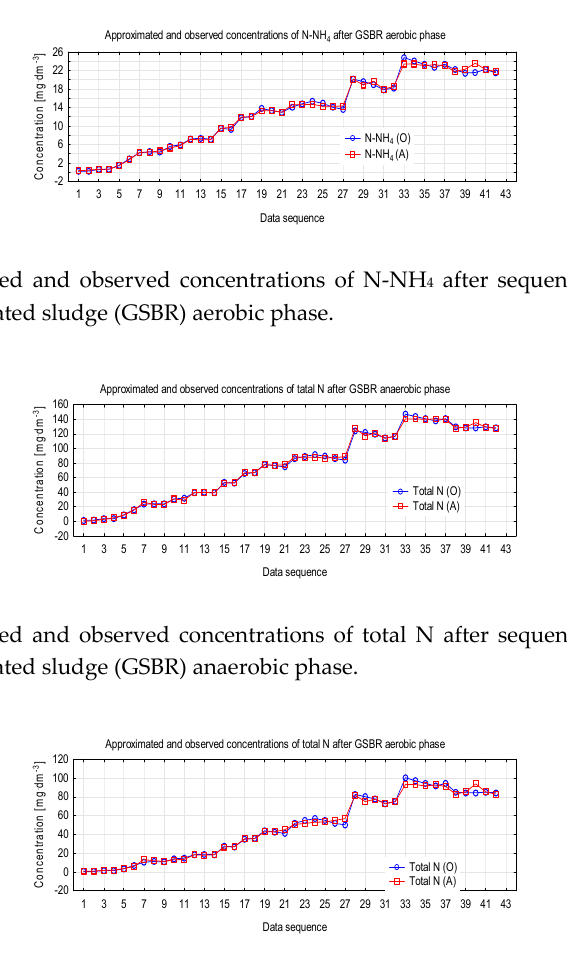
Figure 6. Approximated and observed concentrations of total N after GSBR aerobic